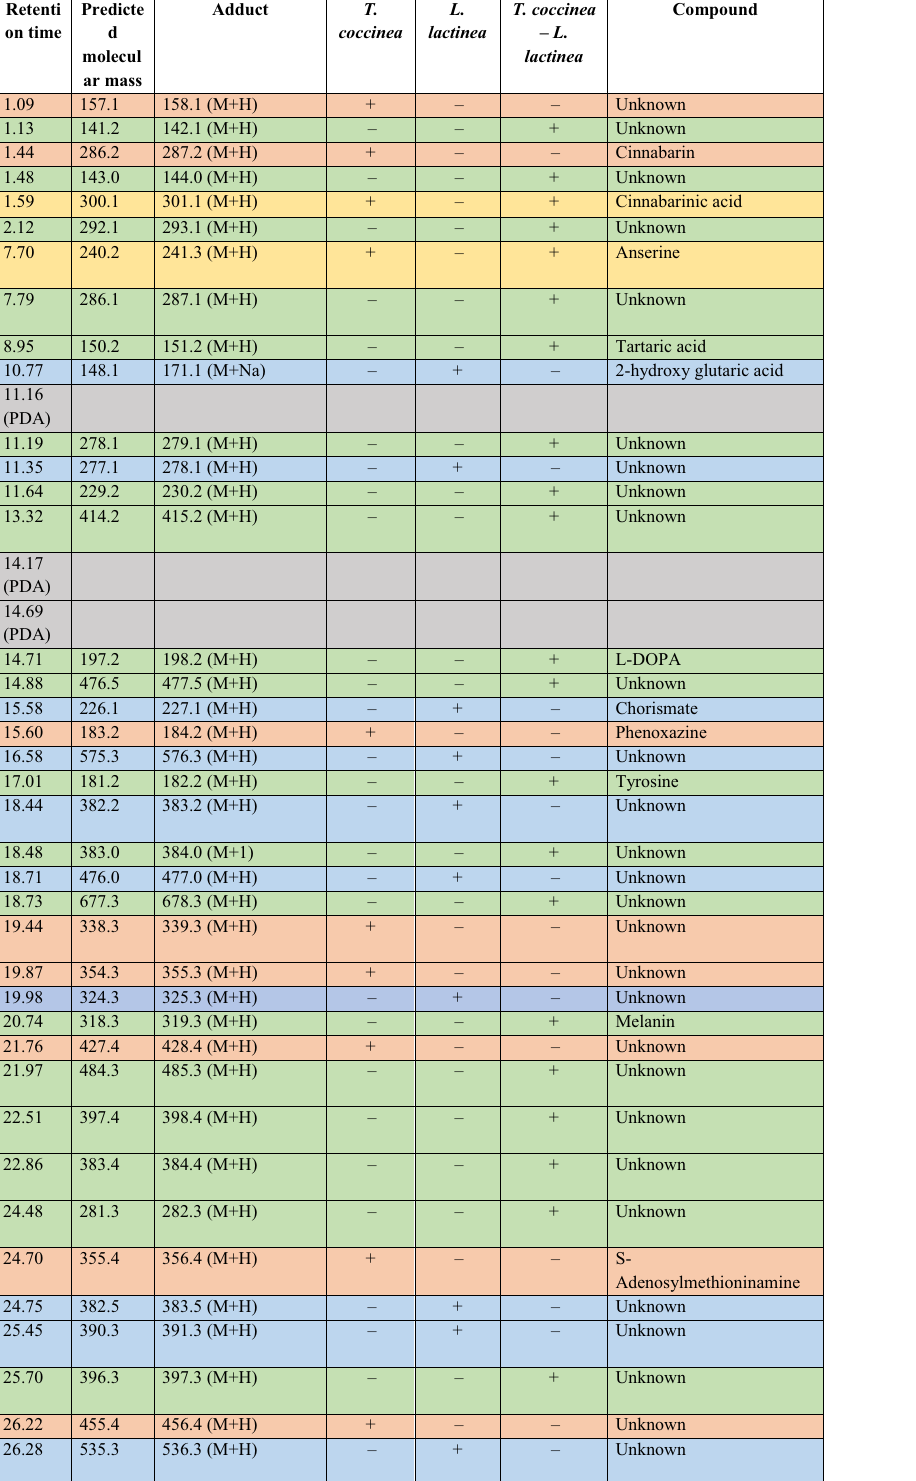
Table 2 Comparative analysis of metabolite profiles during interspecific interactions between T. coccinea – L.